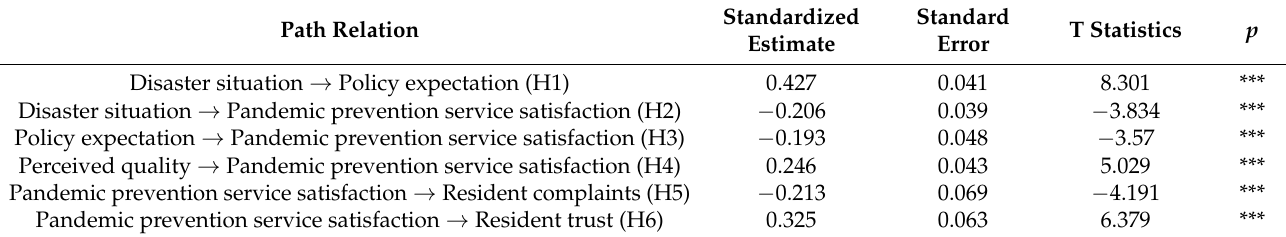
Table 4. The path coefficient between the latent